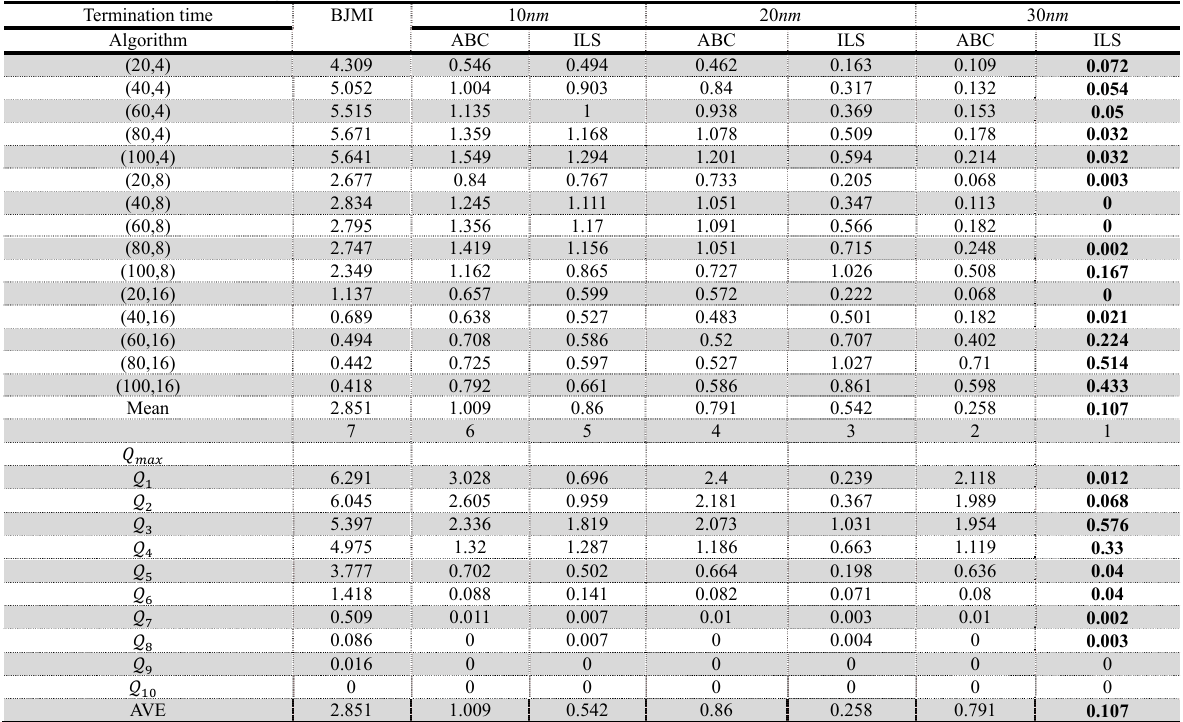
ARPI for metaheuristics (large instances, minimum ARPI values are in bold).